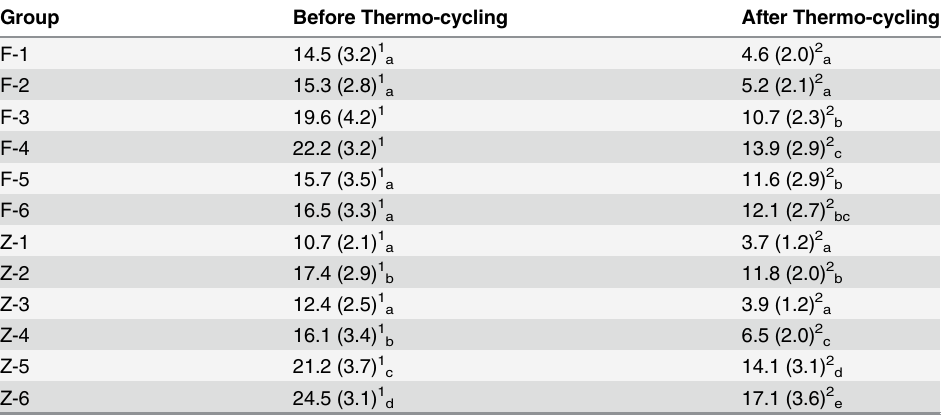
(): SD. For each horizontal row in the mean value of the bond strength: superscript values with different numbers indicate statistically signi fi cant difference (P < 0.05). For each vertical column in the mean value of the bond strength: subscript characters with same letters (a, b, c, d, e) indicate no statistically signi fi cant difference (P > 0.05). The sample size for each experimental group was 15.